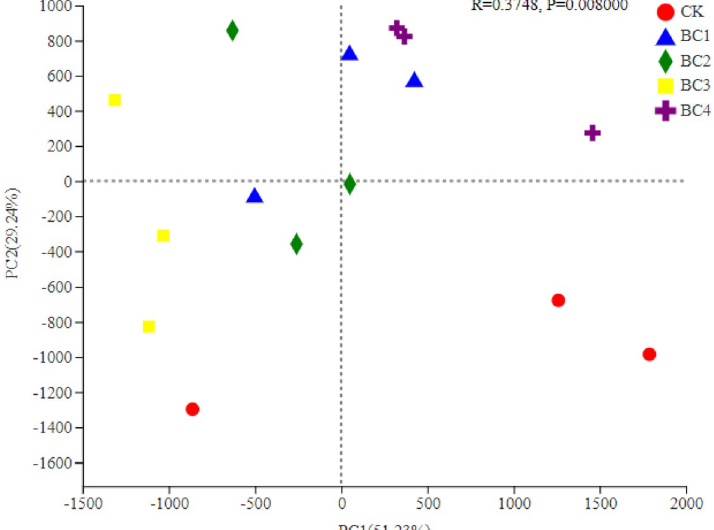
Fig. 3 Principal component analysis of the soil bacterial community structure. Axis 1 (51.23%) and axis 2 (29.24%) explained the variations based on the Bray-Curtis dissimilarities. Treatments CK, BC1, BC2, BC3, and BC4 had biochar dosages of 0%, 0.5%, 1%, 2%, and